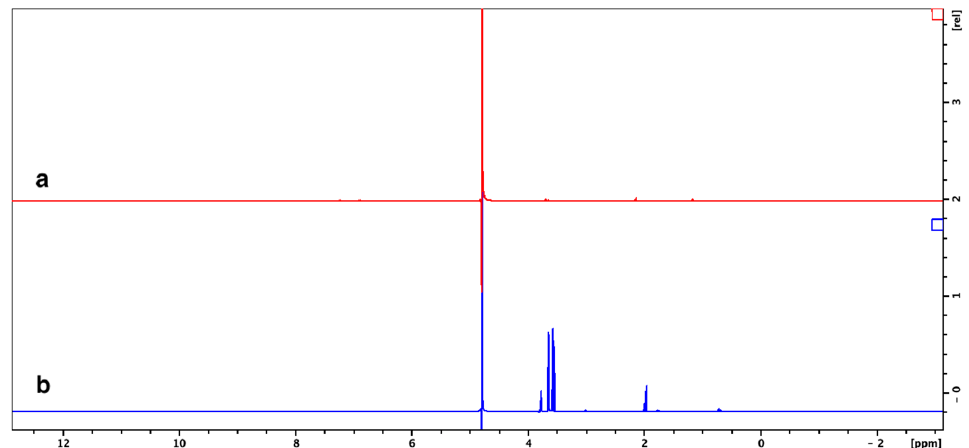
Figure 7. NMR spectra of paracetamol after interaction with HRP ( a ) and LiP ( b ) enzymes at pH = 7 during 5 days.